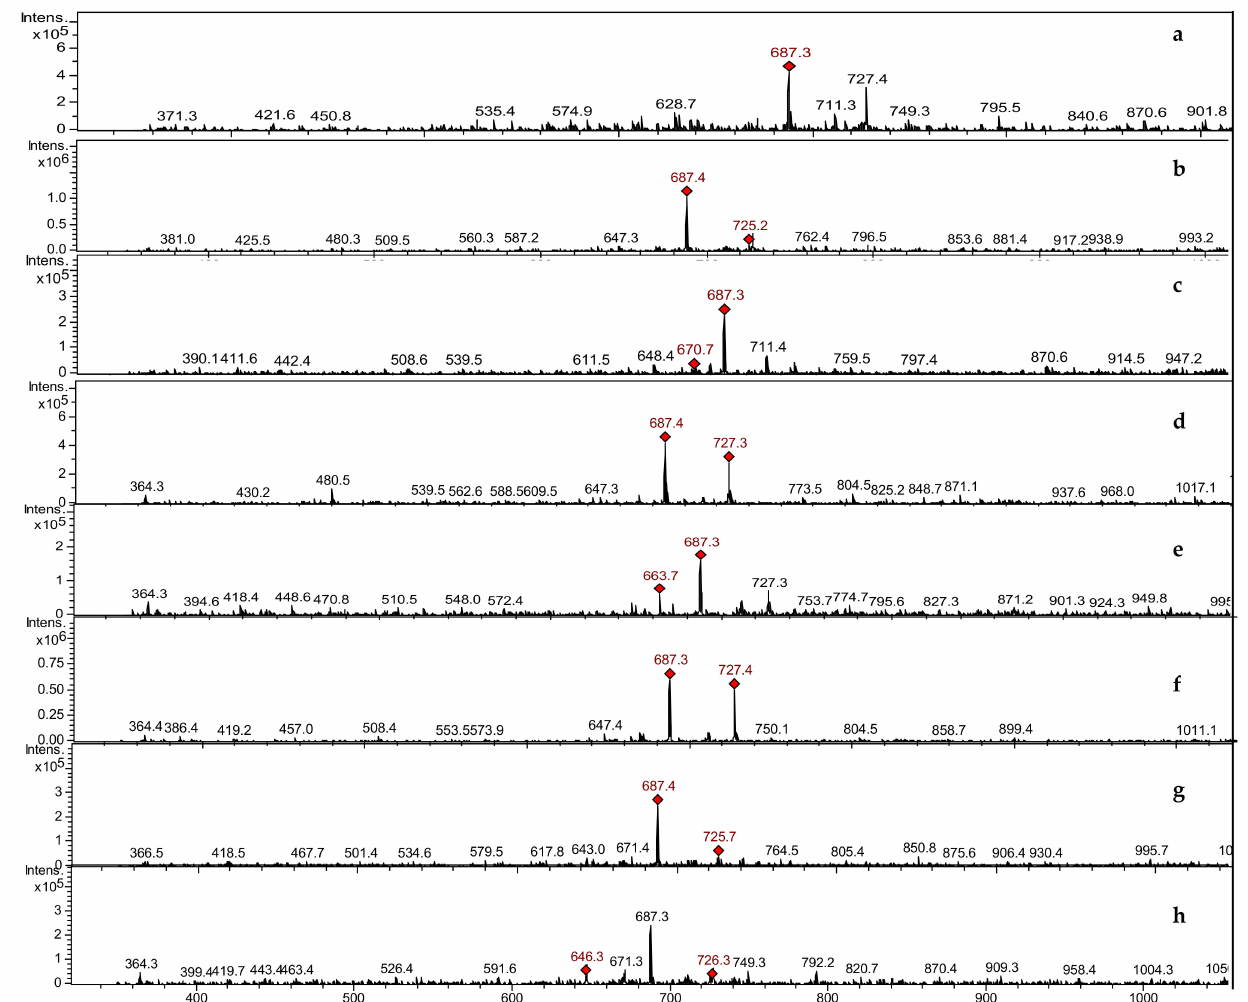
Figure 5. MS spectra recorded in positive mode for the samples obtained after EPSs extraction from the eight lactic acid bacteria strains tested: Fructilactobacillus sanfranciscensis UMCC 2990 ( a ), Lentilacto- bacillus parabuchneri UMCC 2992 ( b ), Leuconostoc citreum UMCC 2993 ( c ), Lactiplantibacillus plantarum UMCC 2996 ( d ), Furfurilactobacillus rossiae UMCC 3002 ( e ), Lactiplantibacillus plantarum UMCC 3009 ( f ), Pediococcus pentosaceus UMCC 3010 ( g ), Leuconostoc citreum UMCC 3011 ( h ). Highlighted in red are the masses that have been subsequently fragmented for MS/MS